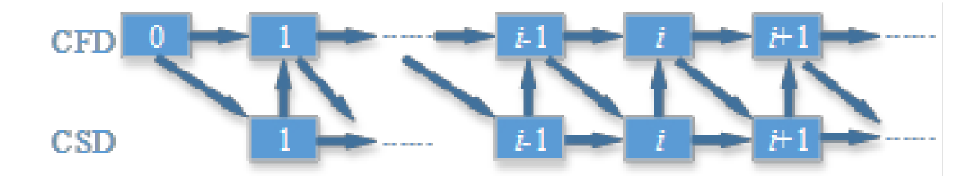
Figure 4. Coupling method 1 between aerodynamics and structural dynamics.